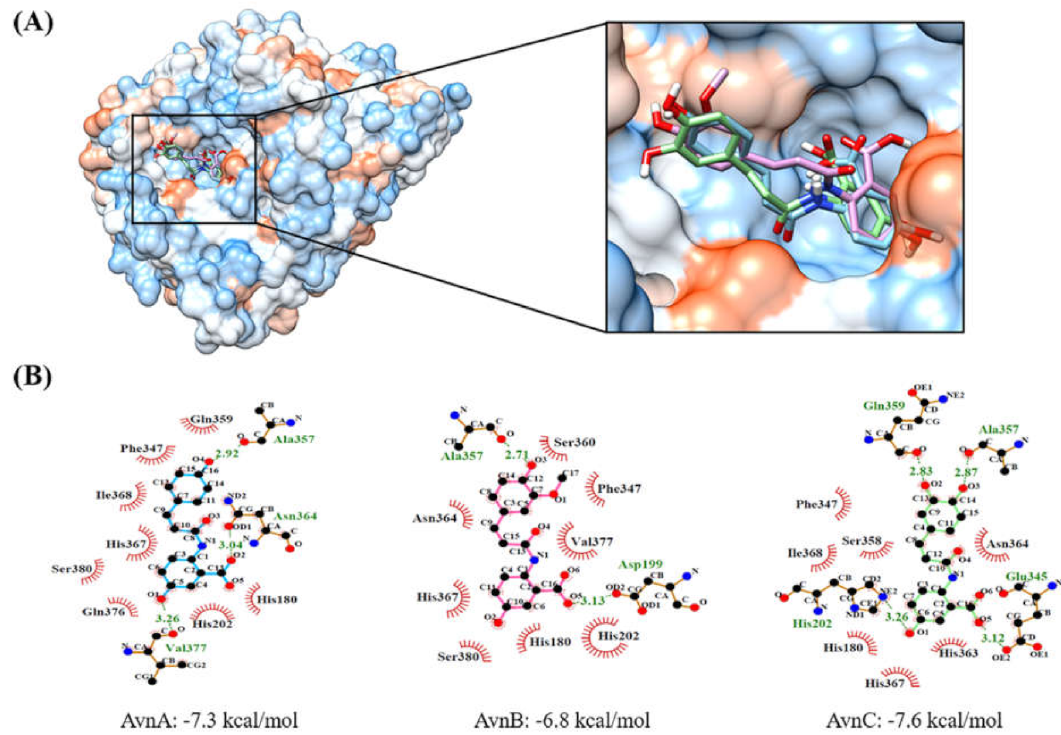
Figure 5. Molecular docking simulation of AvnA, AvnB, and AvnC with human tyrosinase. ( A ) Docking simulations indicated that Avn-A-B-C were located at kojic acid binding sites complexed with tyrosinase. The three phenylpropanoids of each compound were located inside the pocket. The binding affinity of AvnC for tyrosinase ( − 7.6 kcal/mol) was greater than that of AvnA ( − 7.3 kcal/mol) and AvnB ( − 6.8 kcal/mol) according to AutoDock Vina. ( B ) Interaction analysis between tyrosinase and Avn-A-B-C. The Avn-A-B-C had several hydrogen bond interactions at seven residues (Asp199, His202, Glu345, Ala357, Gln359, Asn364, and Val377) on tyrosinase. The four hydrogen bonds between AvnC and tyrosinase resulted in higher binding affinity of AvnC than that AvnB or AvnA. In addition, the Avn-A-B-C had seven or eight hydrophobic interactions with